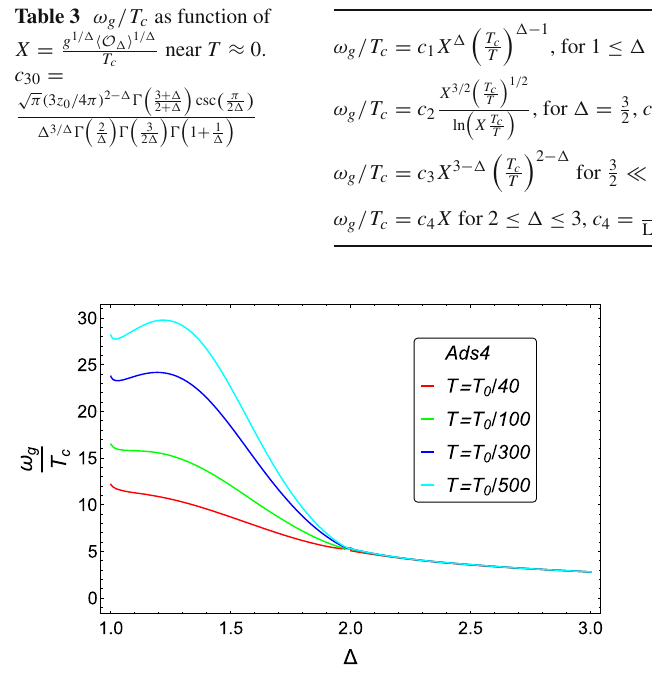
Fig. 8 ω g / T c vs (cid:2) for d = 3. Here, T 0 = ( g ρ) 1 2 . For (cid:2) > 3, it decreases slowly